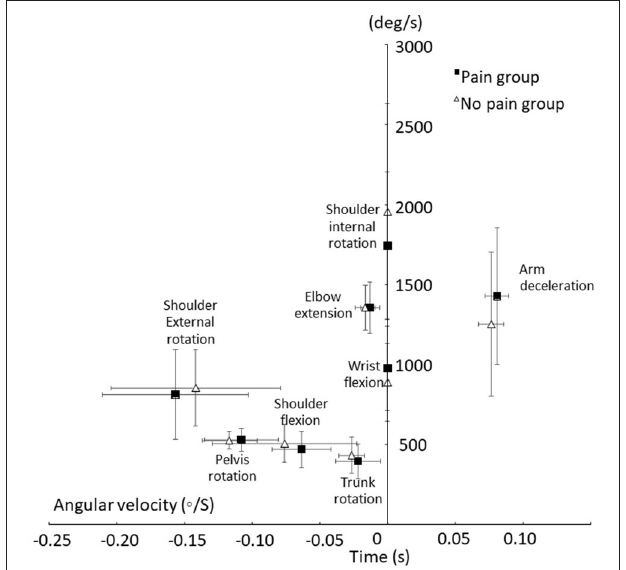
FIGURE 8 | Average ( ± SD) peak shoulder angular velocities and arm angular deceleration velocity and time of occurrence until ball release for the pain and no pain